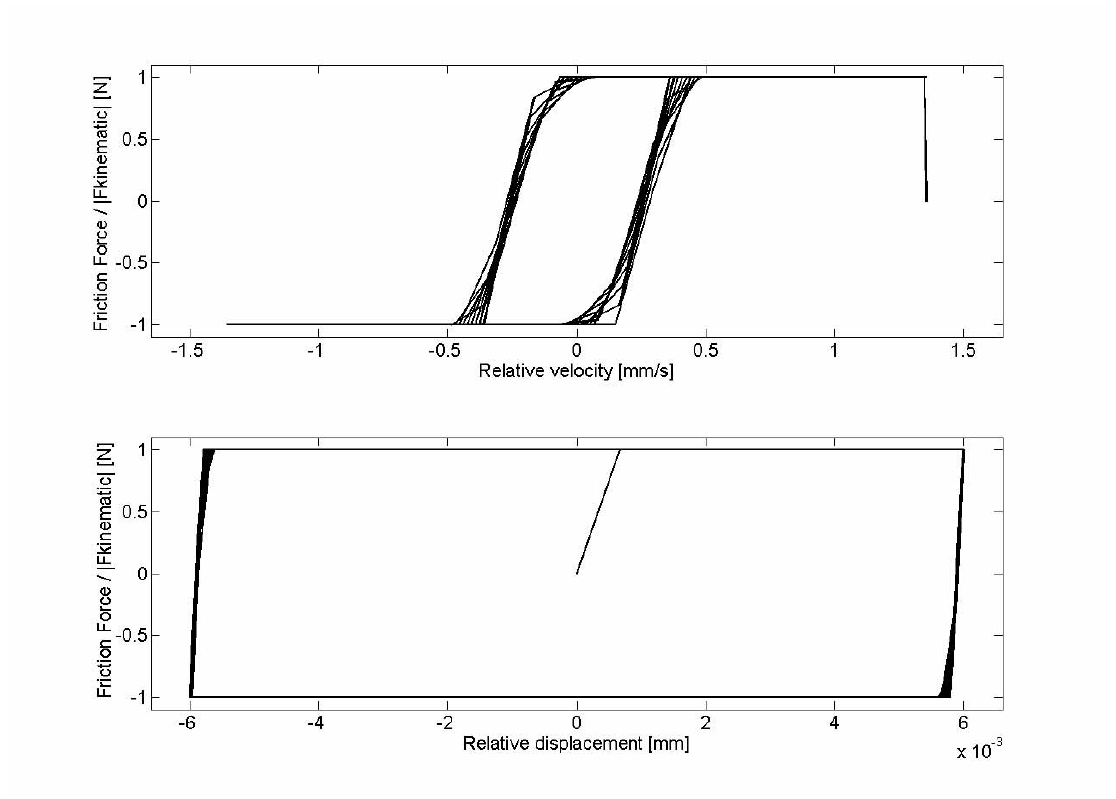
Fig. 7. Behavior of the nonlinear friction